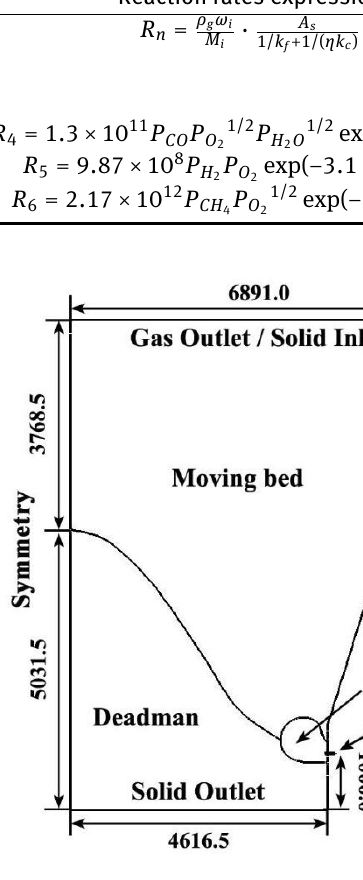
Table 2: Chemical reactions considered in this work n Chemical reactions